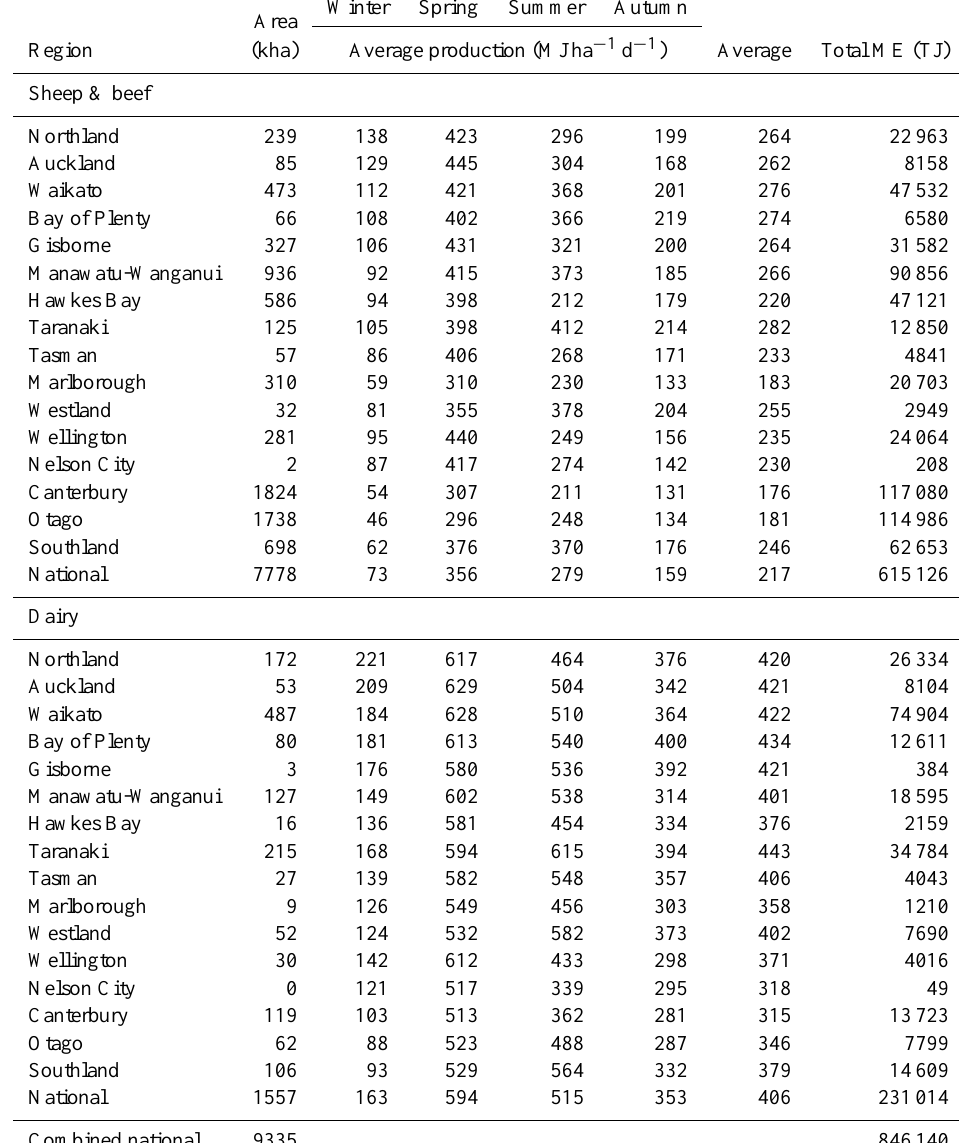
Table B1. Baseline average production by region and season over the period 2001–2009 in units of metabolisable energy. Winter Area